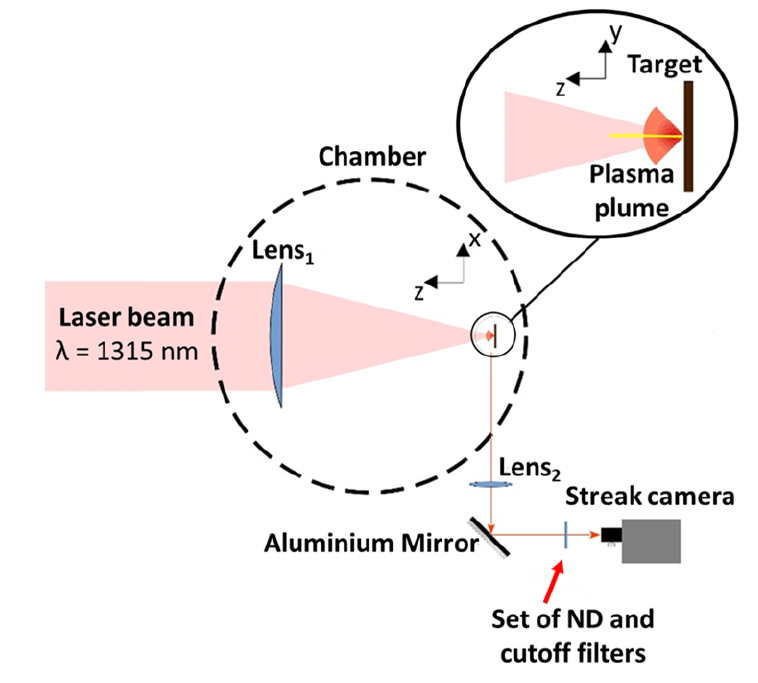
Figure 2. Experimental setup for the measurement of the laser plume longitudinal expansion